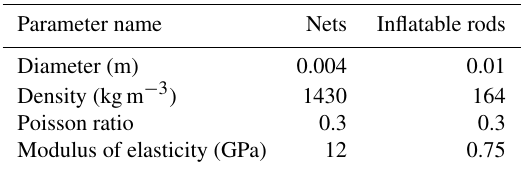
Table 2. The material parameters of the inflatable deployment rod and rope